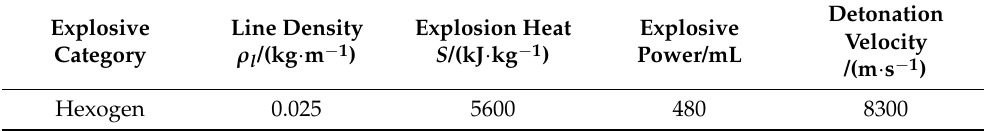
Table 3. Explosive performance.